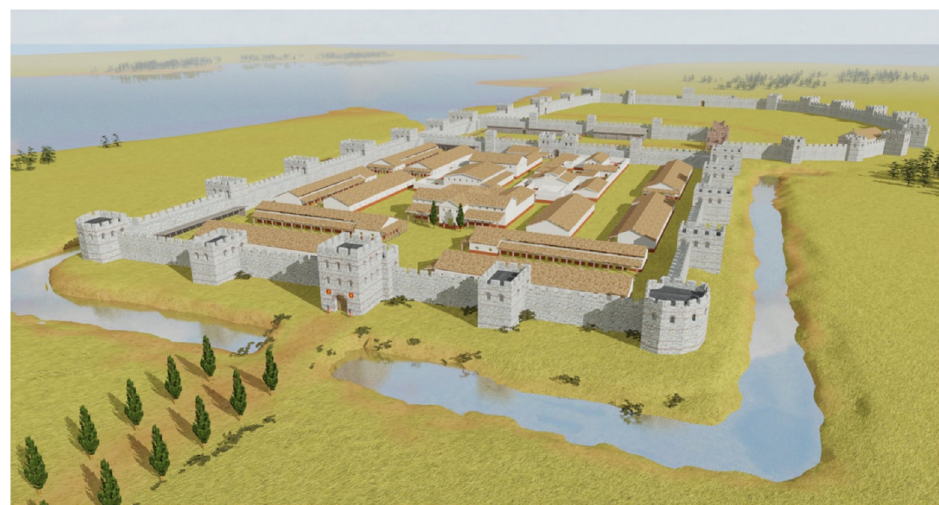
Figure 12. Reconstruction of the general view of the fortress “Great Pitiunt”.